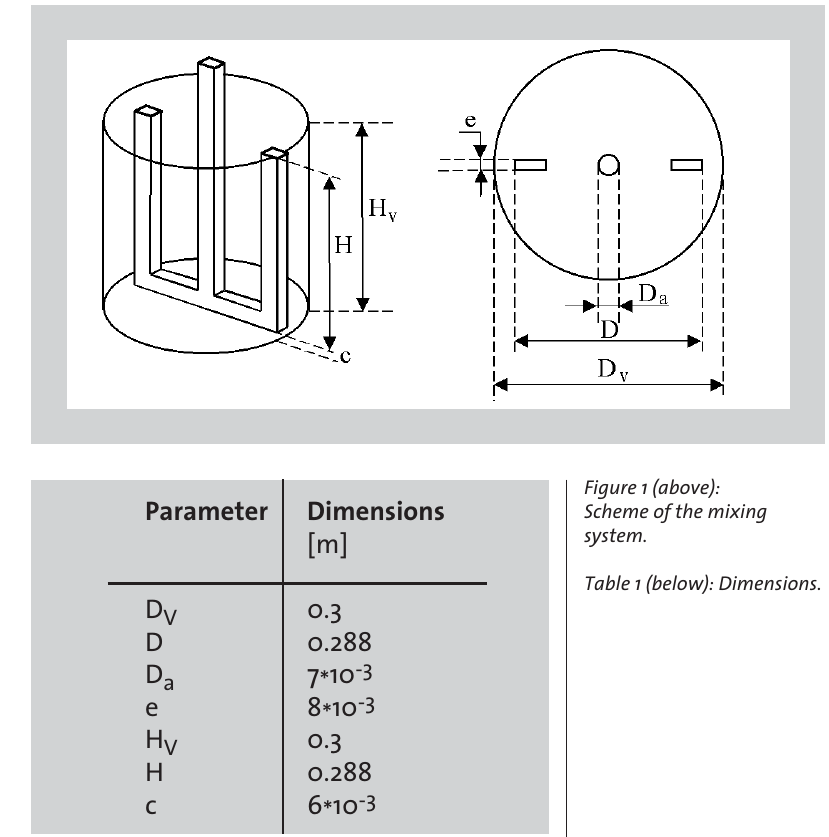
Figure 1 (above): Scheme of the mixing system. Table 1 (below):